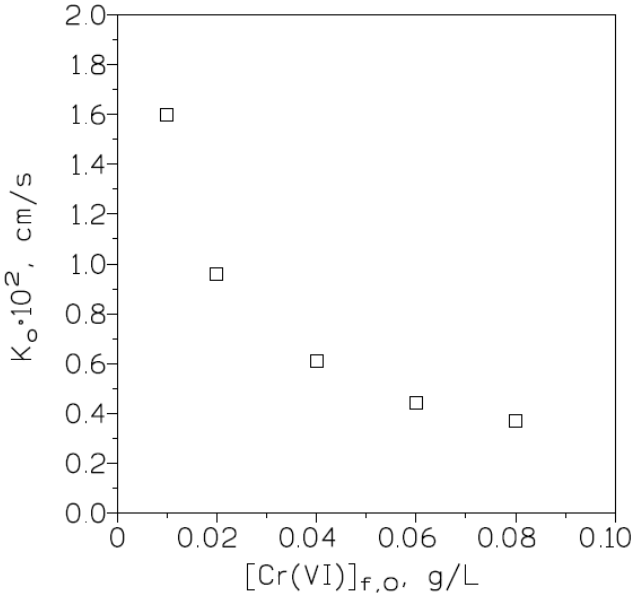
Figure 5. Plot of K 0 versus initial chromium(VI) concentration in the feed phase for metal transport investigations using a 0.5 M Cyanex 923 in Solvesso 100 solution as carrier phase.